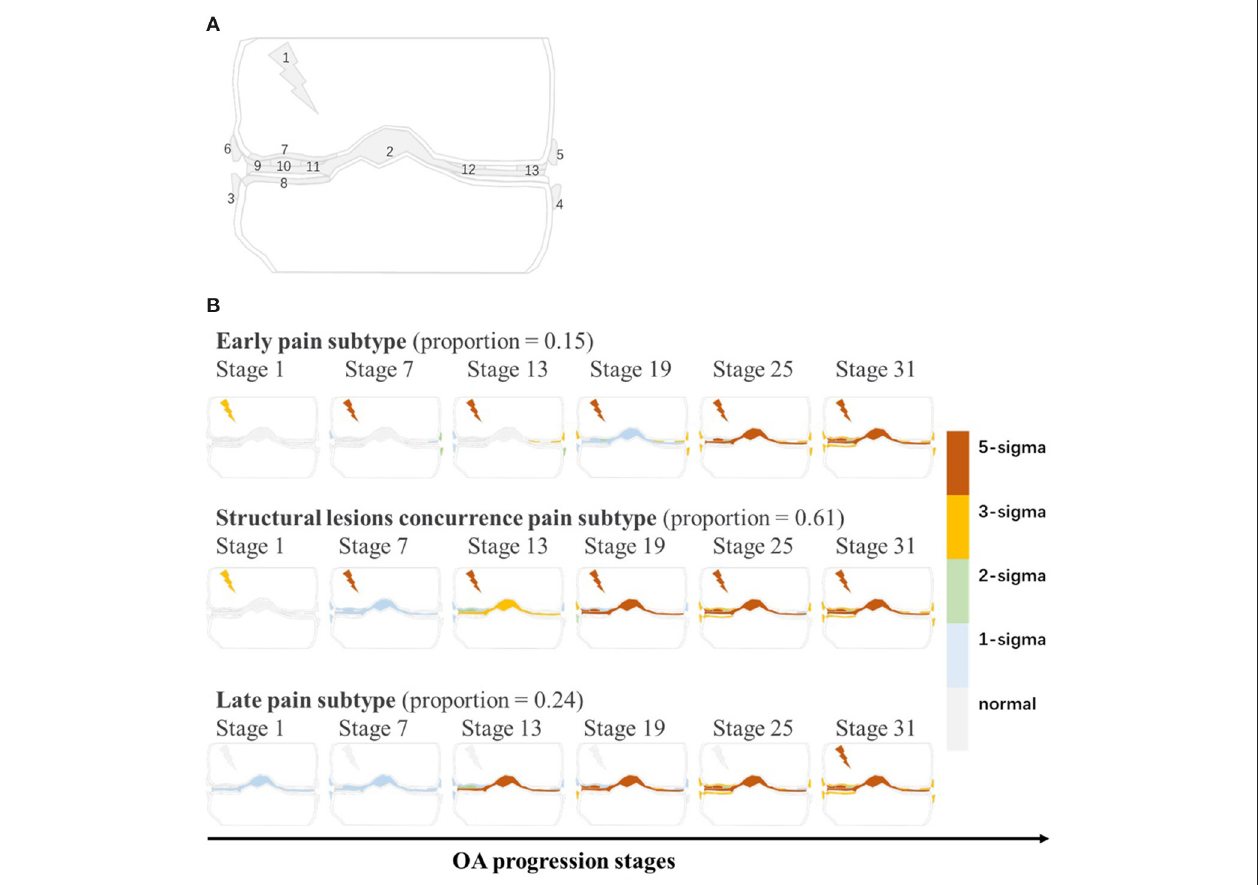
FIGURE 2 | (A) The graphical representation of all biomarkers. Gray line is coronal sketch map of knee joint. Numbers in this figure match the order numbers of biomarkers in Table 1 . (B) KOA subtypes and subtype biomarker progress sequences identified by subtypes-progression model. Proportion of knees assigned to each subtype are shown. Each row represents an biomarkers changes order as KOA stages advance. Biomarkers from different stages reach different z-scores relative to control group. At each stage color in each region indicates level of severity of pain or lesions: gray is unaffected; blue is mildly affected (z-score of 1), and so